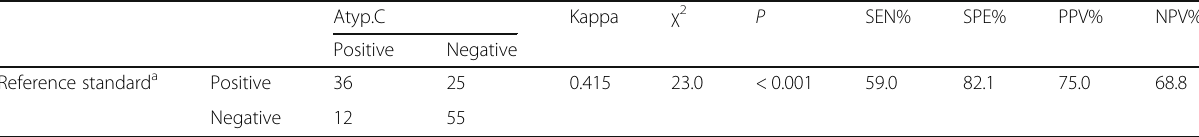
Table 4 Cross-tabulation of a histologic diagnosis on follow up biopsies and Atyp. C test results